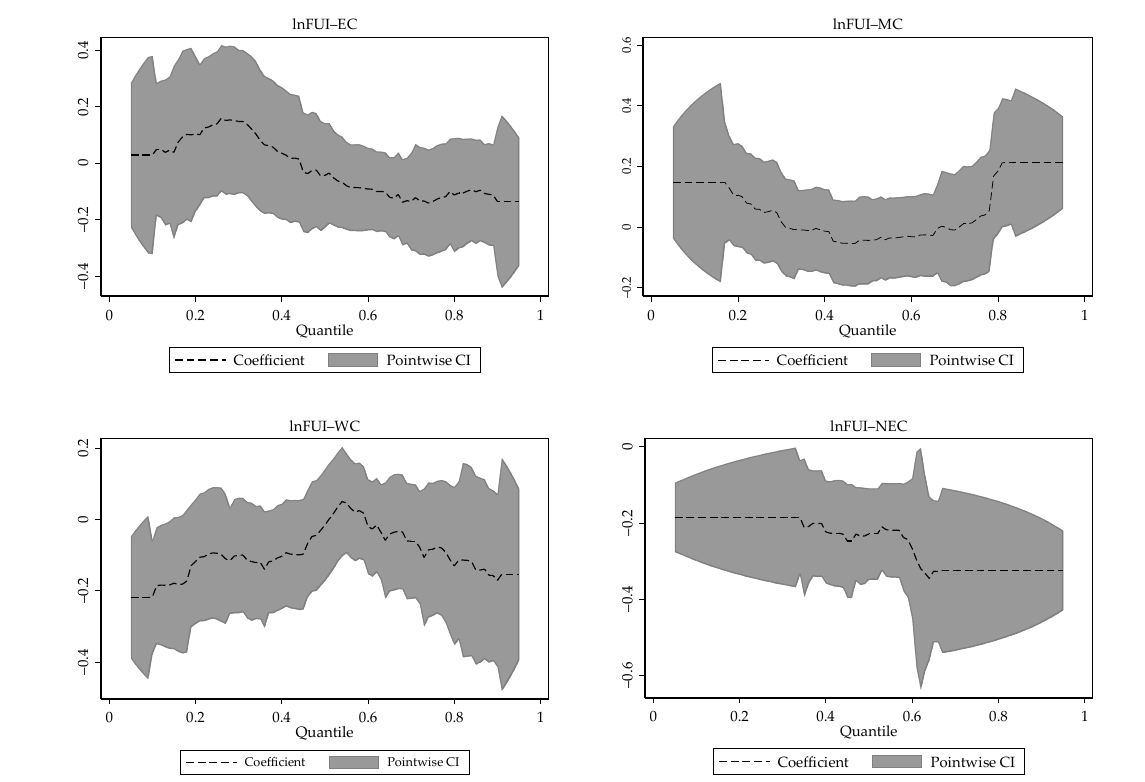
Figure A1. Variation of FUI coefficients in economic subdivisions at different quartiles.